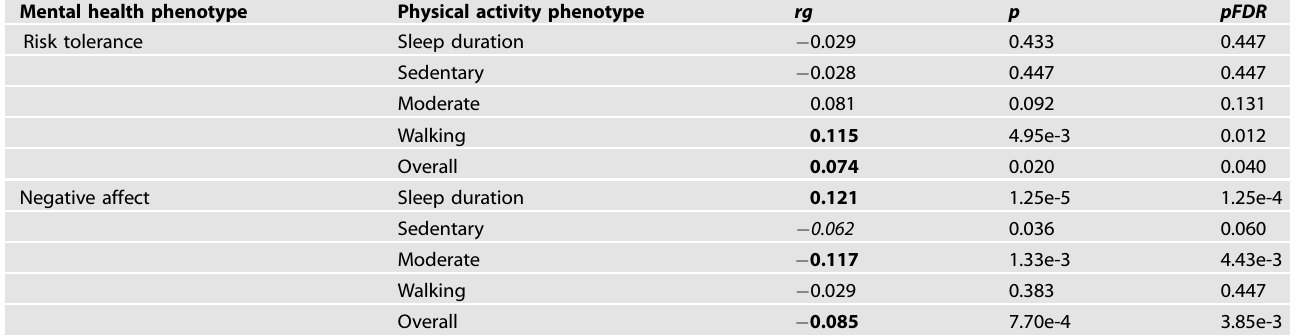
Table 3. Genetic correlations between mental health and physical activity phenotypes. Mental health